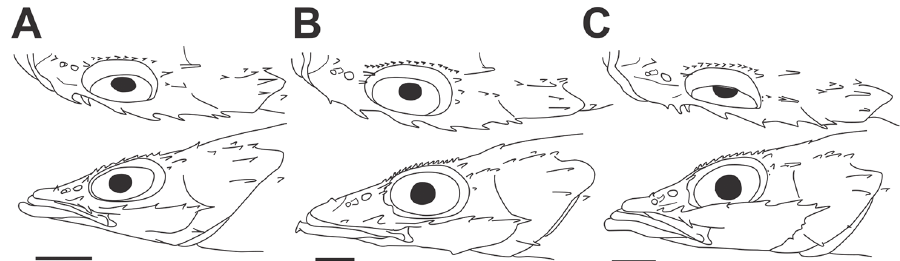
Figure 2. Lateral and dorsal views of the head of the three species of Parabembras ; A P. curta , FAKU 41447, 143.5 mm SL B P. robinsoni , NSMT-P 129791, 165.1 mm SL C P. multisquamata , holotype, MNHN-IC-2008-1516, 167.3 mm SL. Bars equal to 10